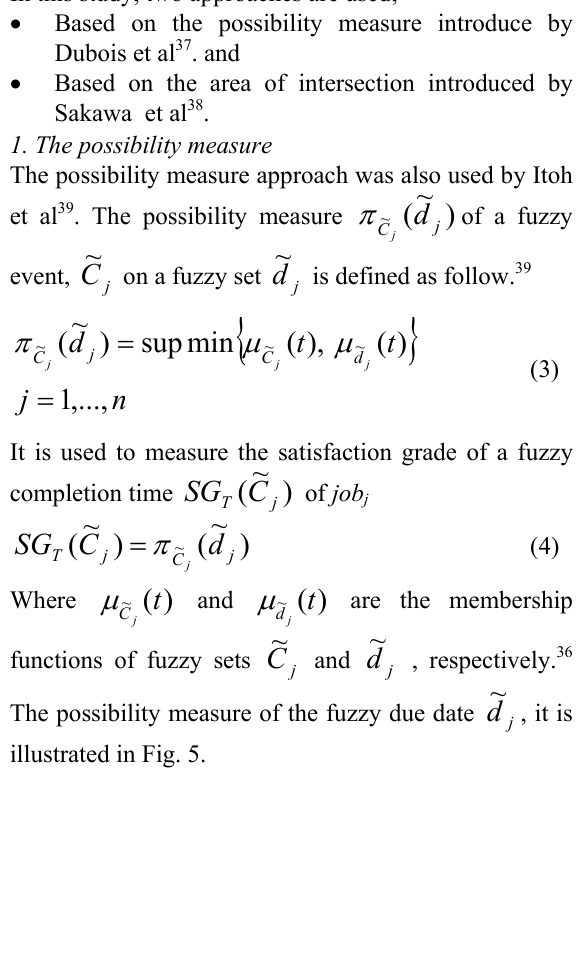
)~ ( ~ d  of the fuzzy due jC j